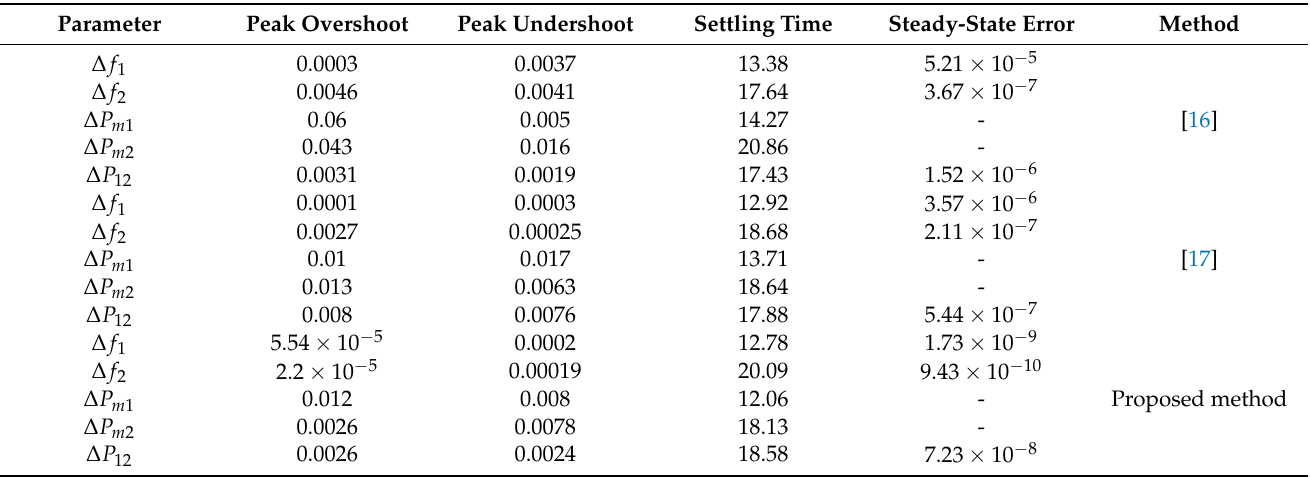
Table 2. Comparison of transient specifications of the proposed approach with other existed works for unit step load demand change.